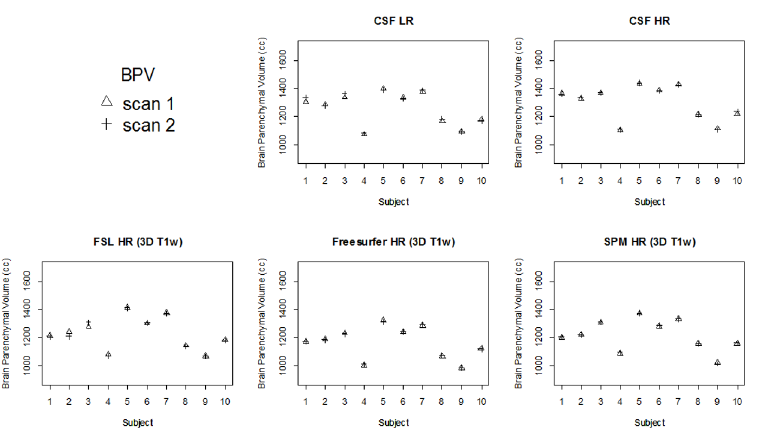
Fig 4. All BPV measurements for all methods in each subject. CSF LR = CSF low resolution MRI scan; CSF HR = CSF high resolution MRI